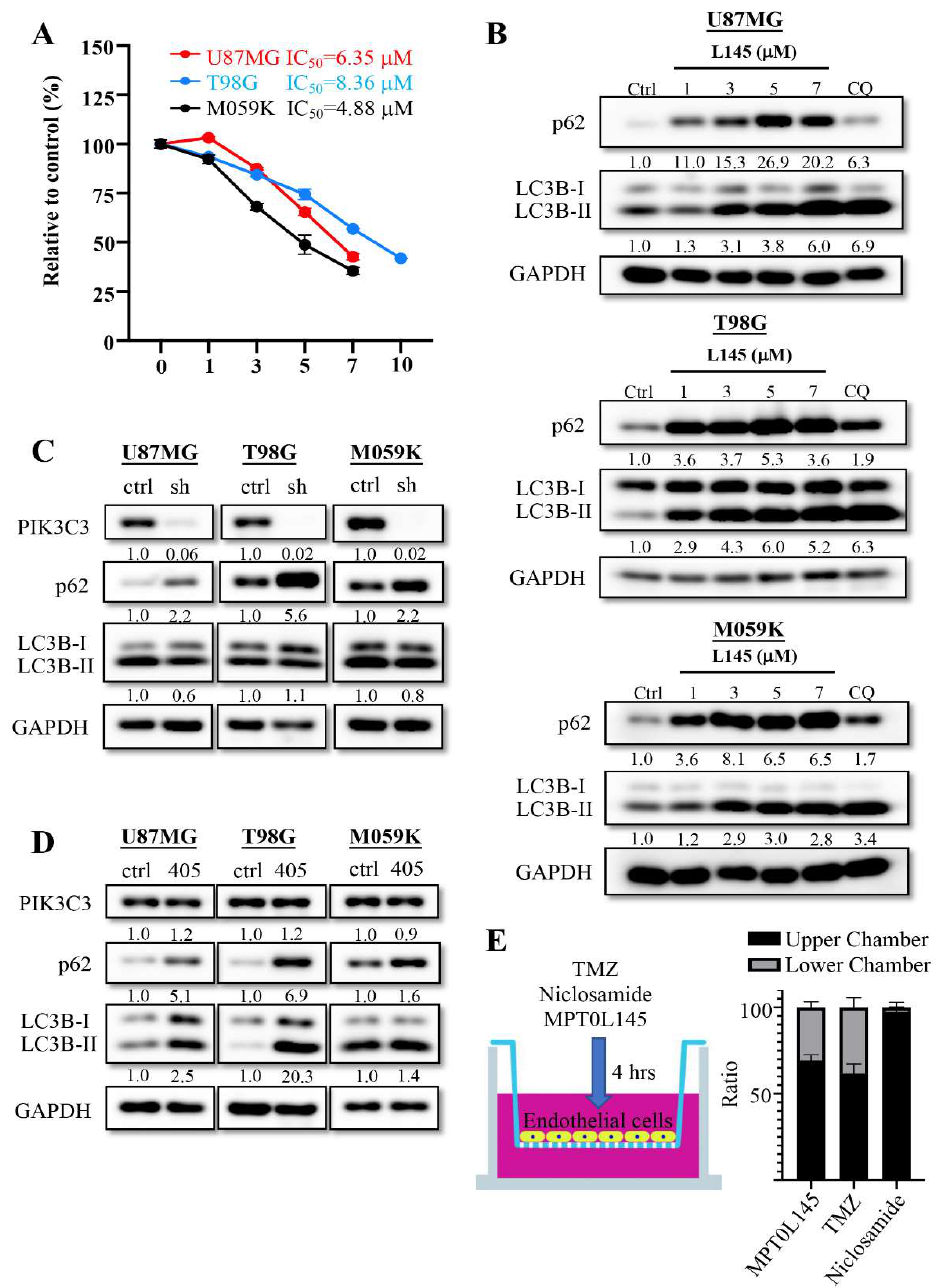
Figure 3. MPT0L145 increases incomplete autophagy in U87MG, T98G and M059K cells. ( A ) The three cancer cells were treated with MPT0L145 for 72 h and the IC 50 value was evaluated using MTT assay. Data are presented as the mean ± SD of triplicate wells, and are representative of two independent experiments. ( B ) The three cancer cells were exposed to the indicated concentrations ( µ M) of MPT0L145 and chloroquine (12.5 µ M) for 24 h. The protein lysates were subjected to Western blot analysis with the indicated antibodies (Figure S3). ( C ) PIK3C3 was stably depleted in the three cancer cells and the levels of indicated proteins were detected via Western blot analysis (Figure S3). ( D ) The three cancer cells were exposed to the PIK3C3 inhibitor SAR405 (10 µ M), for 24 h. Protein lysates were subjected to Western blot analysis with the indicated antibodies (Figure S3). ( E ) TMZ, Niclosamide and MPT0L145 were injected into the upper chamber of the ready-to-use BBB kit for 4 h. The supernatants of the upper and lower chambers were collected and analyzed by LC/MS/MS. The ratio was calculated as the concentration of indicated chamber/(concentration of lower chamber plus concentration of upper chamber) × 100% and the data are presented as the mean ± SD of four trans